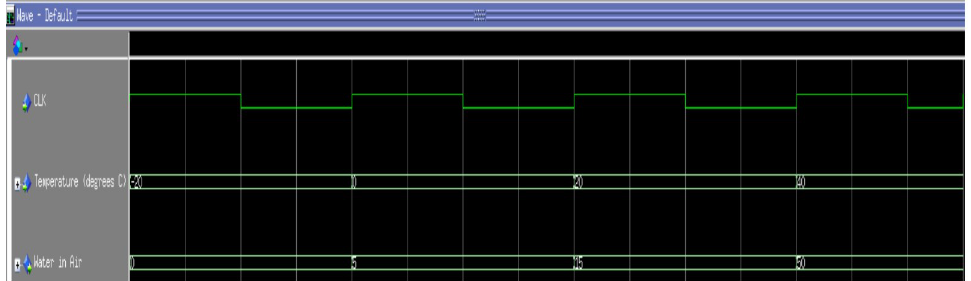
Figure 7. Results of the simulation of the intelligent monitoring